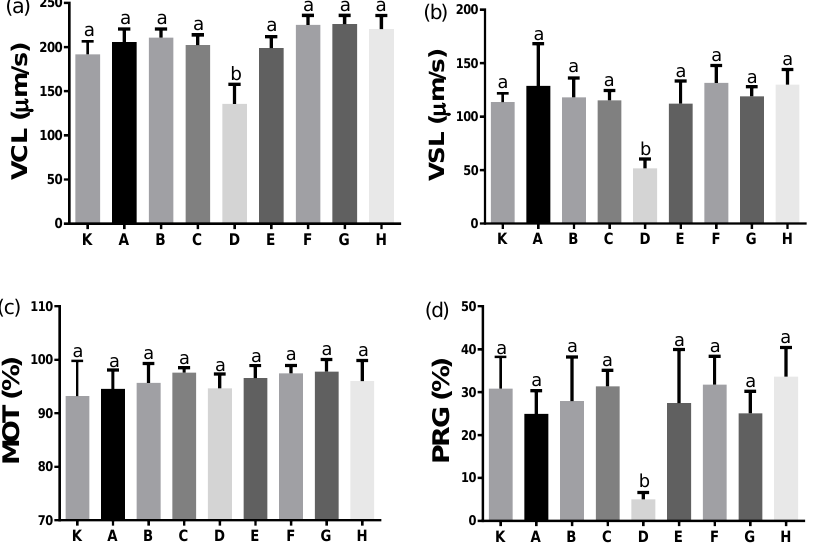
Figure 1. Determination of the influence of different activating buffers on the perch sperm motility parameters: ( a ) VCL, curvilinear velocity of sperm, ( b ) VSL, straight-line velocity, ( c ) MOT, motile sperm and ( d ) PRG, progressive sperm, (K — control, hatchery water; A —„Lahnsteiner” liquid, pH 7.0, 100 mM NaCl, 10 mM Tris; B —„Lahnsteiner” liquid, pH 8.0; C—„Lahnsteiner” liquid, pH 9.0; D — 10 mM Tris, 10 mM NaCl, pH 8.5; E — 20 mM Tris, 40 mM NaHCO 3 , pH 8.5; F —„Woynarovich” liquid, 0.3% urea, 0.4% NaCl; G — 10 mM HEPES, 100 mM NaCl, pH 8.0 and H — 80 mM NaCl, 20 mM KCl, 10 mM Tris, pH 8.0). Values are shown as a mean ± SD, p ≤ 0.01, n = 4. Different letters (a, b) indicate the statistically significant differences between the activating buffers ( p ≤ 0.01). The data were analysed using a repeated measure one-way analysis of variance (ANOVA), followed by Tukey’s post hoc test. Figure 2. Determination of the influence of different activating buffers on the perch embryonic sur- vival rate (72 h after fertilisation) (K — control, hatchery water; A —„Lahnsteiner” liquid, pH 7.0, 100 mM NaCl, 10 mM Tri;, B —„Lahnsteiner” liquid, pH 8.0; C—„Lahnsteiner” liquid, pH 9.0; D— 10 mM Tris, 10 mM NaCl, pH 8.5; E — 20 mM Tris, 40 mM NaHCO 3 , pH 8.5; F —„Woynarovich” liquid, 0.3% urea, 0.4% NaCl; G — 10 mM HEPES, 100 mM NaCl, pH 8.0 and H — 80 mM NaCl, 20 mM KCl, 10 mM Tris, pH 8.0). Values are shown as a mean ± SD, p ≤ 0.01, n = 3. Different letters (a, b) indicate